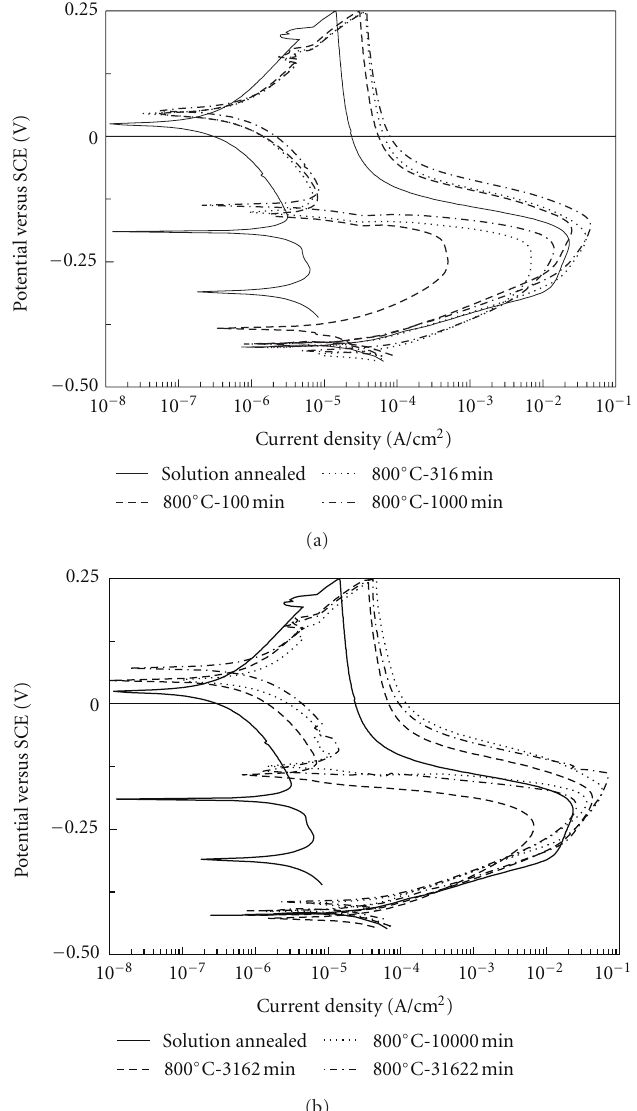
Figure 8: DLEPR curves plotted for DSS after solution and sensitization heat treatments at 800 ◦ C between 100 and 31622 min (scan rate: